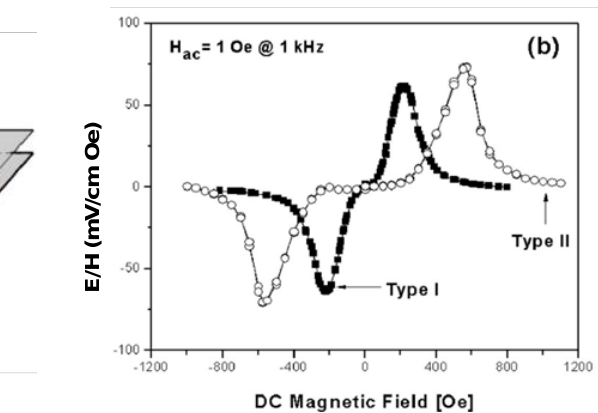
Figure 21. (a) Schematic diagram and (b) ME voltage coefficients for PZNT/Metglas bilayer and Metglas/PZNT/Metglas trilayer